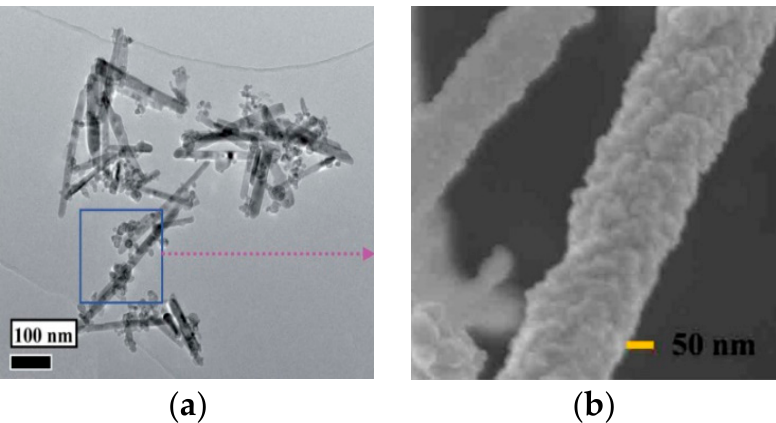
Figure 5. ( a ) A low-magnification TEM image of the as-prepared ZnFe 2 O 4 /ZnO nano heterostructures; ( b ) SnO 2 /ZnO nanowire